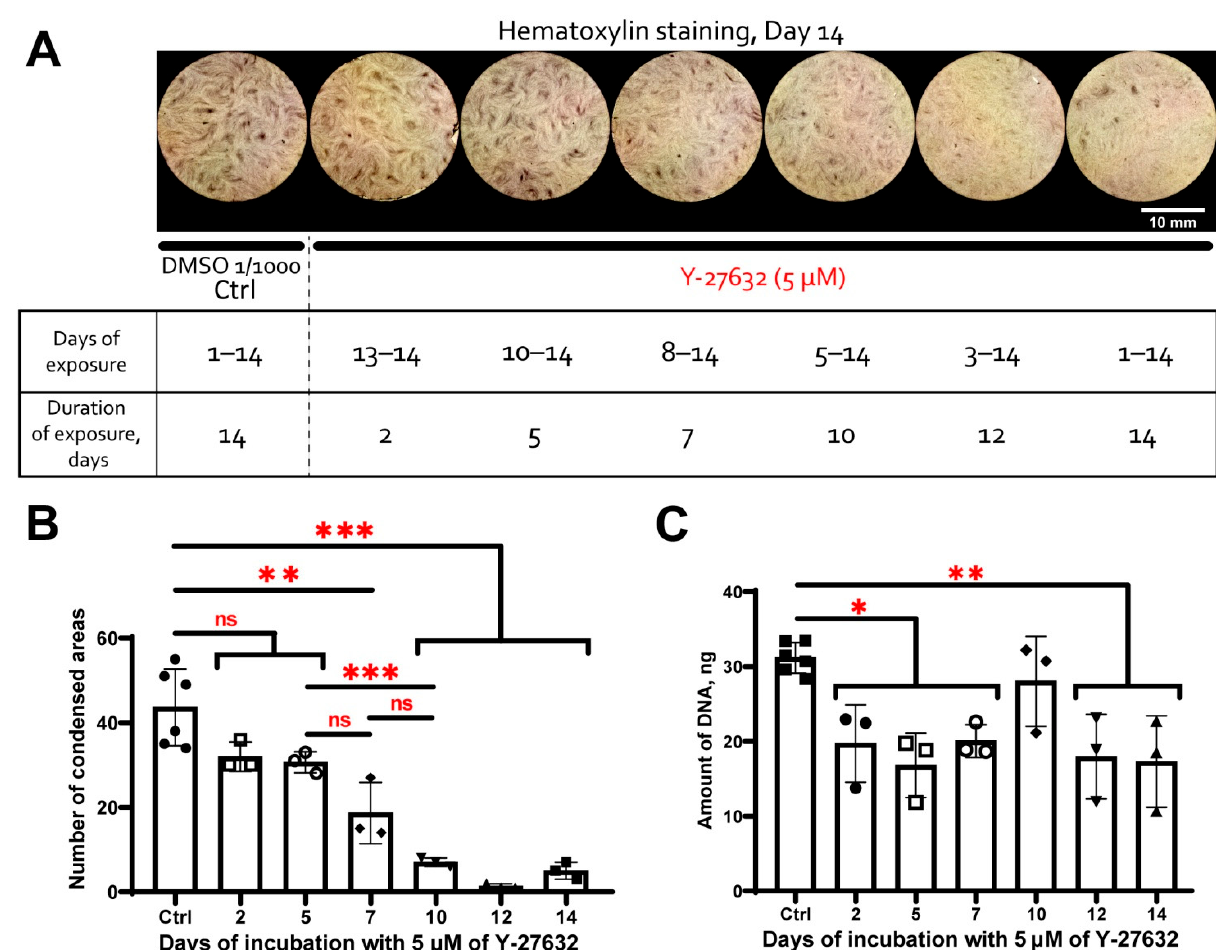
Figure 9. MSC condensation is disrupted by suppression of the Rho/ROCK-1/2 signaling pathway. ( A ) Cell sheet general view at Day 14 of incubation with Y-27635. Hematoxylin staining, macro photographs of a 12-well plate well. ( B ) Comparative analysis of the condensed areas number after the inhibition of Rho/ROCK-1/2 of different durations. Condensed areas number by Day 14 is reduced by the ROCK-1/2 inhibitor (Y-27632) at the early stages of CS formation (Days 0–7). ( C ) Comparative analysis of the DNA amount measured in the respective ( A , B ) cell culture lysates after Rho/ROCK-1/2 inhibition. The proliferation of MSC is impaired by Y-27632, but no significant difference between the experimental time points was demonstrated. ROCK1/2-dependent suppression of cellular proliferation has a constant exposure-independent profile and provides a uniform background. In the figure graphs and histograms, significant differences were marked by * ( p < 0.05), ** ( p < 0.005) or *** ( p < 0.0005) and not significant differences were marked by ns ( p > 0.05).